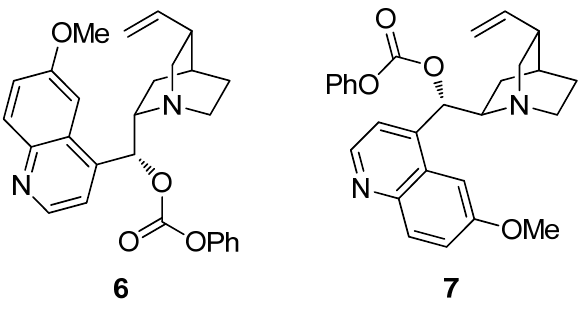
Figure 2. Benzoylquinine (BQ) ( 6 ) and benzoylquinidine (BQd) ( 7 ).